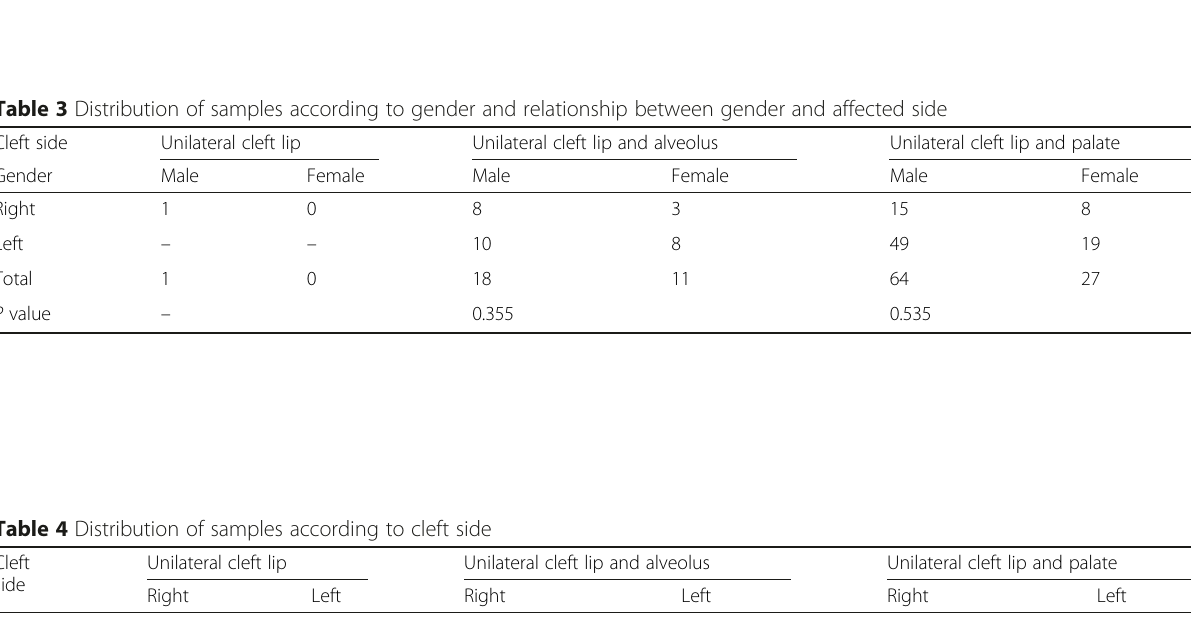
Table 5 Number of missing teeth in unilateral cleft lip and alveolus and unilateral cleft lip and palate subjects